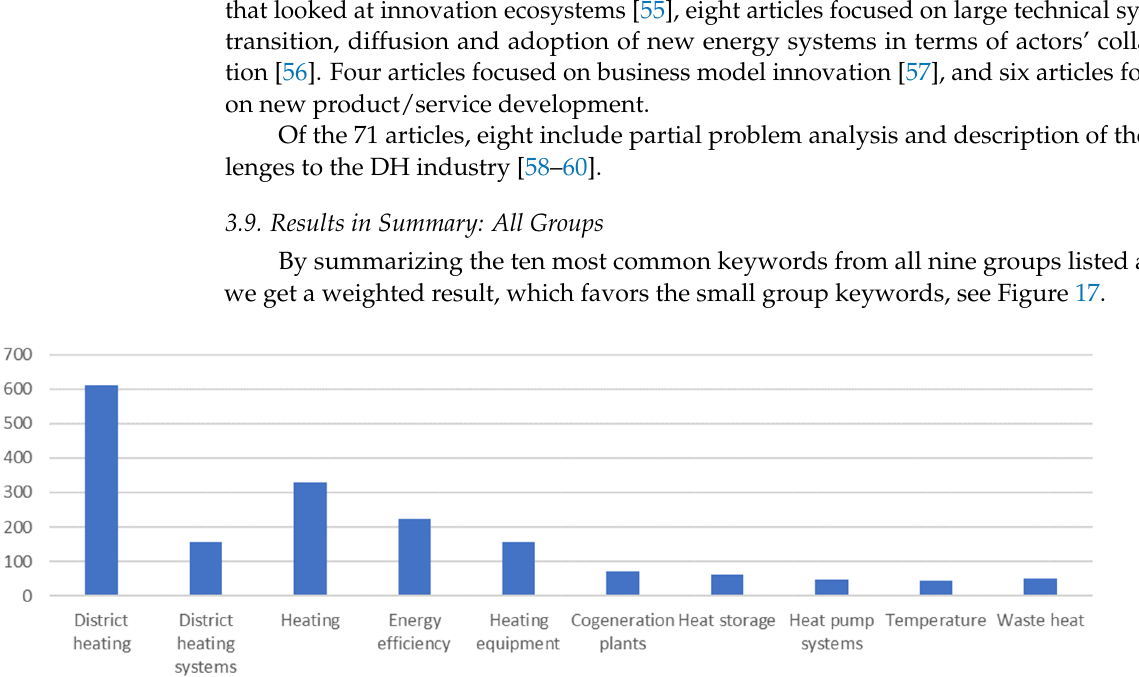
Figure 16. Business—most frequent keywords (horizontal axis) and the number of articles (vertical axis).